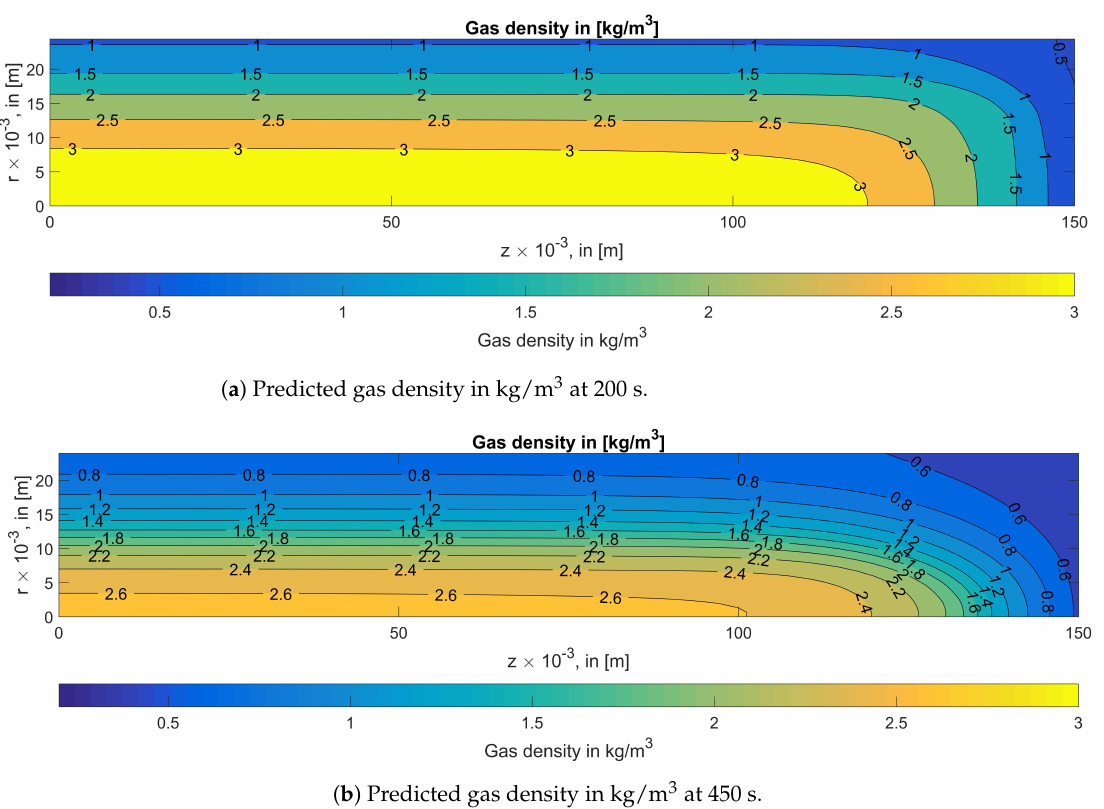
Figure 6. Gas densities in kg/m 3 at 200 s and 450 s during devolatilization. The top of the wood log is at z = 150 mm, and the lateral shell surface of the wood log is at r = 25